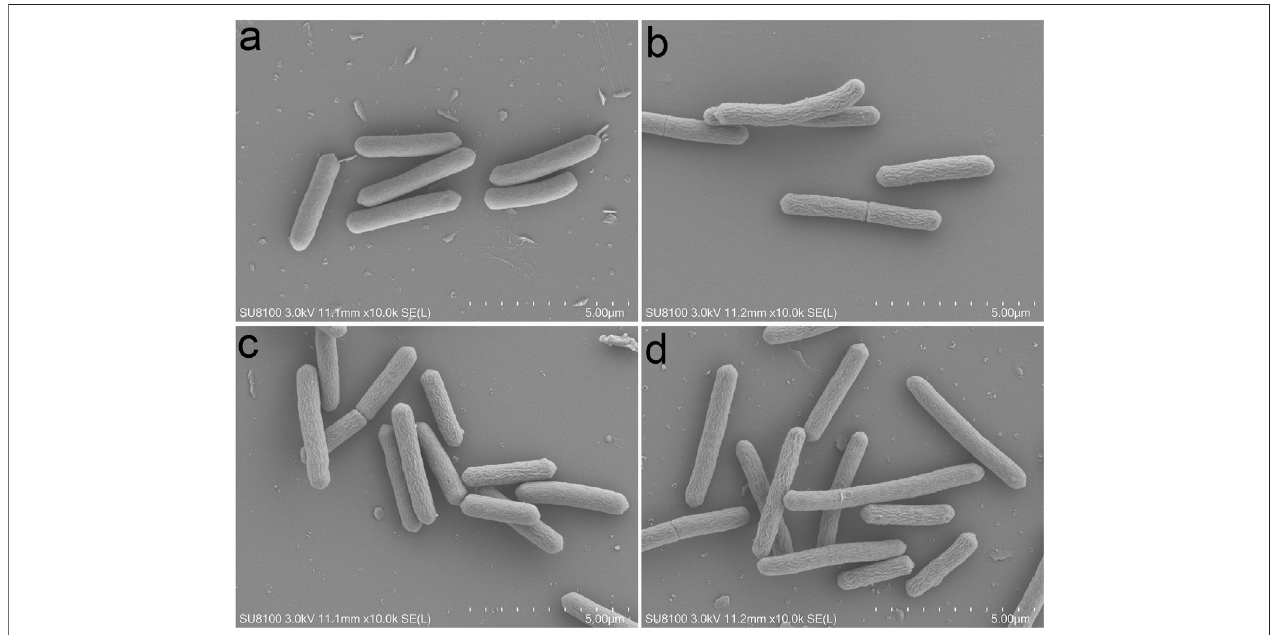
FIGURE5| Morphology of C.dif fi cile observed bySEM after drugs treatment for2 h. (A) Blank. (B) PFPE at 16 μ g/ml. (C) IBCL at 8 μ g/ml. (D) 4MBCL at 8 μ